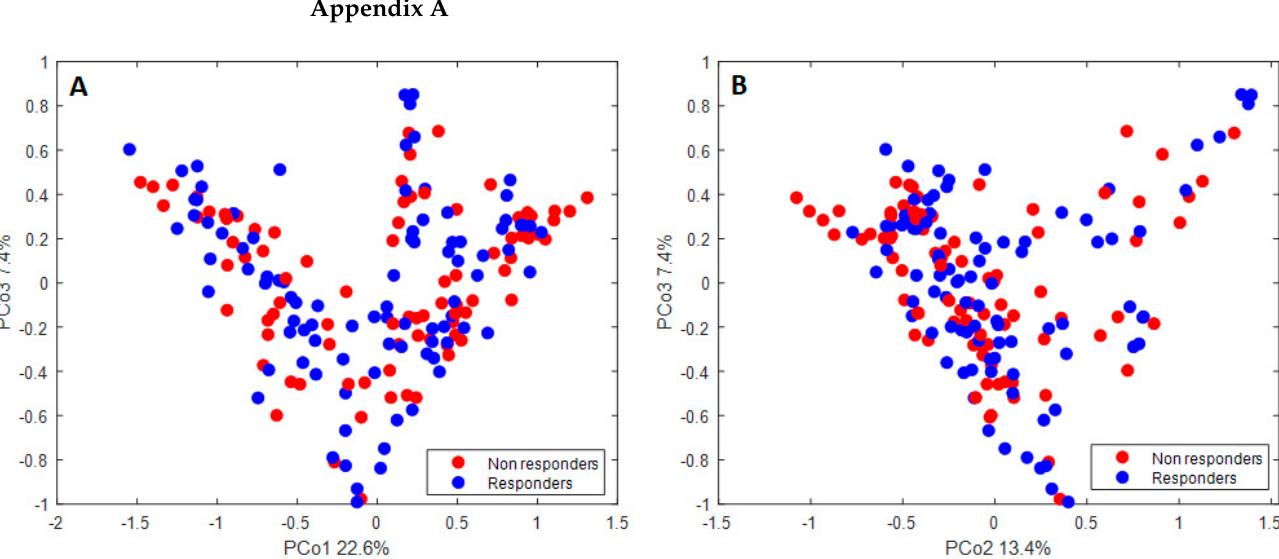
Figure A1. Principal Coordinate Analysis score plot for ( A ) PCo1 and PCo3, and ( B ) PCo2 and PCo3 on a proximity matrix obtained from the Random Forest model performed on training set and 20 most discriminatory volatile organic compounds. The samples are color-coded with respect to the responsiveness to ICS treatment, with blue dots being responders and red ones being non-responders. The figure demonstrates no natural clustering with respect to ICS responsiveness. PCo: Principal Coordinate; ICS: inhaled corticosteroids.